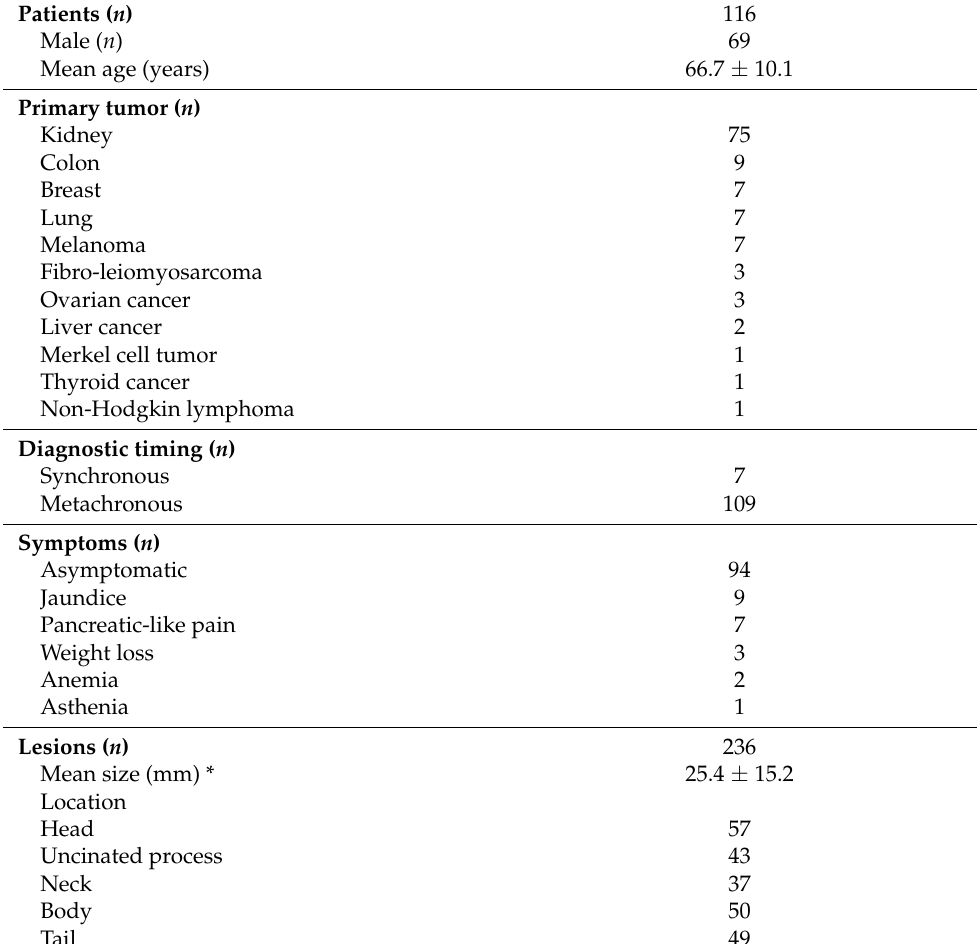
Table 1. Baseline characteristics. * 79 lesions >20 mm, 110 lesions 10–20 mm, 47 lesions < 10